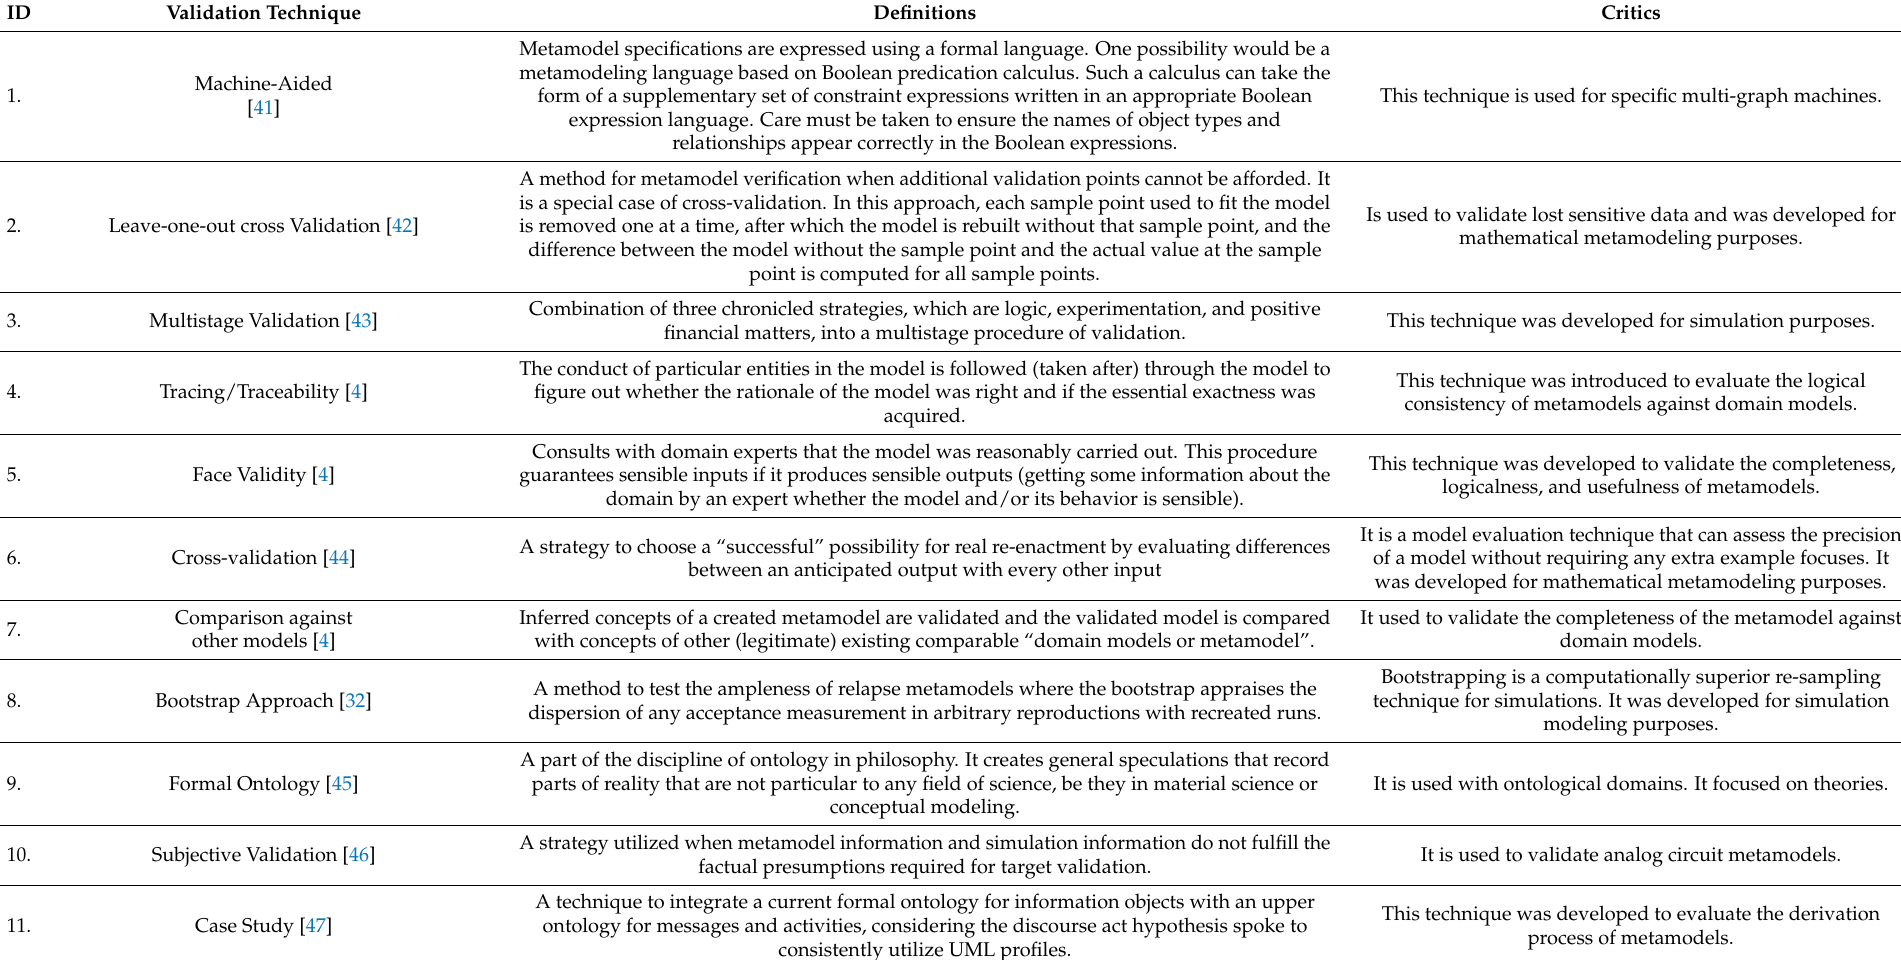
Table 1. Metamodel validation